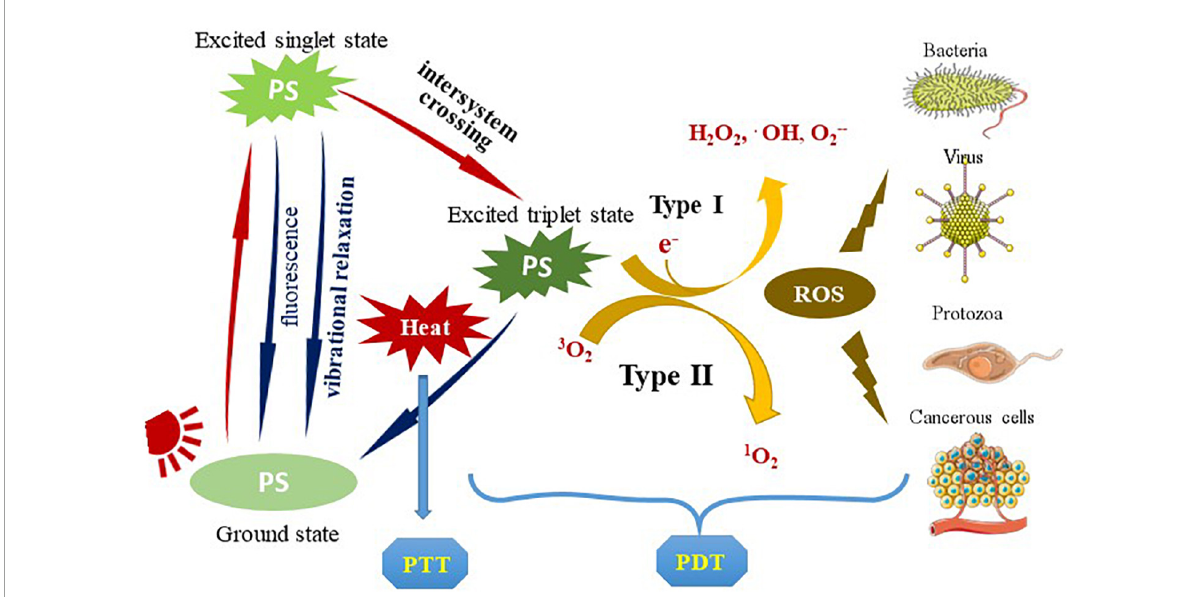
FIGURE1 The types and principles of the photosensitizer-based therapies. PS is transformed into an excited singlet state after being irradiated by light. Partially return to the ground state by emitting fluorescence or non-radiative decay, or it can undergo intersystem crossing to the excited triplet state. It partially returns to the ground state by a radiative or non-radiative process, which is usually accompanied by photothermal conversion (used for PTT). The generation of ROS is subsequently promoted by two types of chemical reactions: type I mechanism generates free radicals and radical ions through electron transfer reactions; type II mechanism involves the reaction of PS with molecular oxygen, where the energy is transferred to the triplet ground state molecular oxygen to generate singlet oxygen. ROS acts on pathogenic microorganisms or tumor cells to produce photodynamic effects (used for PDT). PS, photosensitizer; PTT, photothermal therapy; ROS, reactive oxygen species; PDT, photodynamic